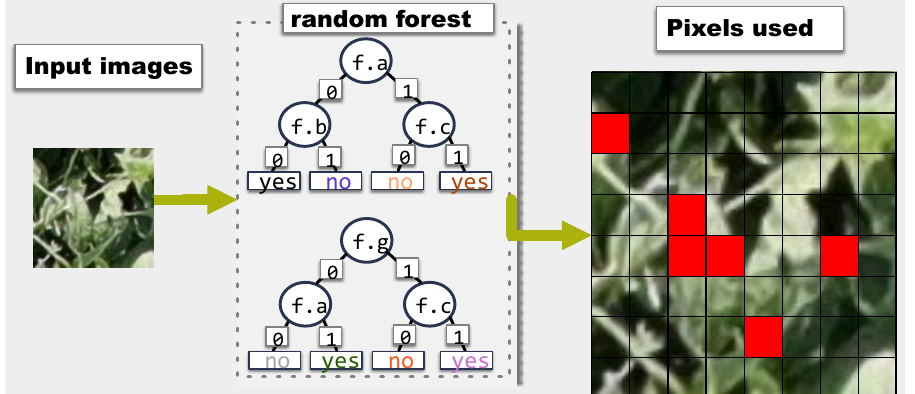
Figure 5. Example of feature coverage when considering individual pixels on an 8 × 8 image. Pixels in red are used for classification.